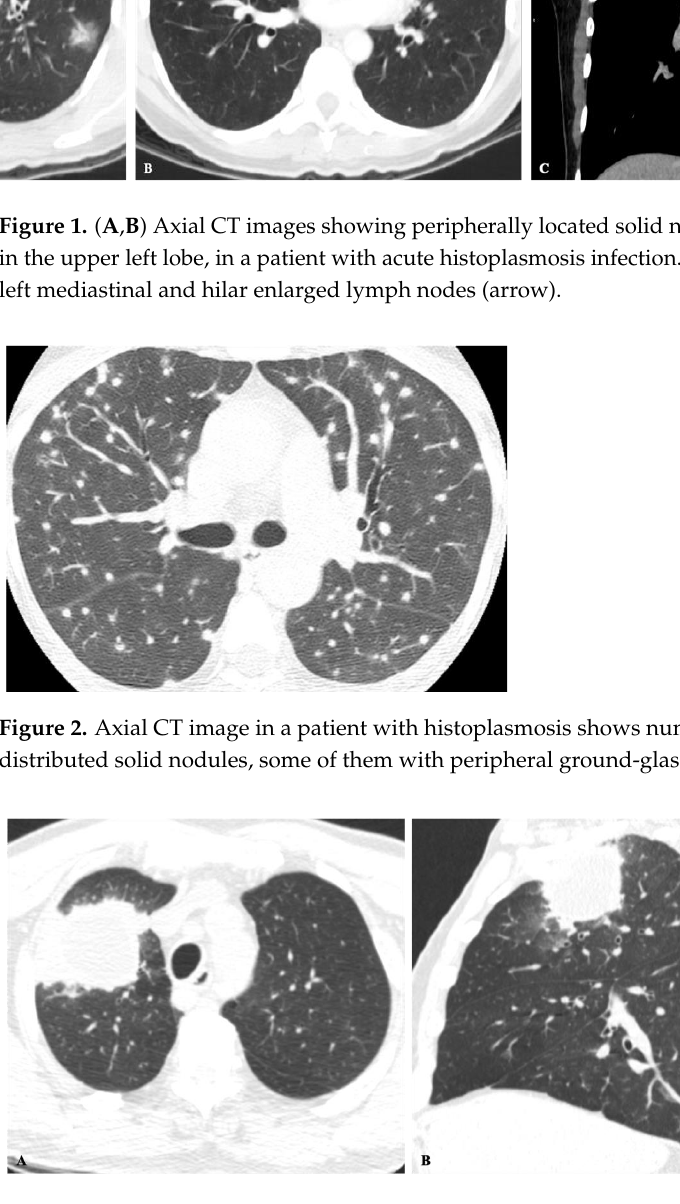
Figure 3. Cryptococcosis in a 63-year-old man with clinical history of colon cancer, heavy smoking and cough for 3 months. ( A ) Axial and sagittal ( B ) images show an irregular solid mass in the right upper lobe adjacent to the pleura and ground-glass halo.